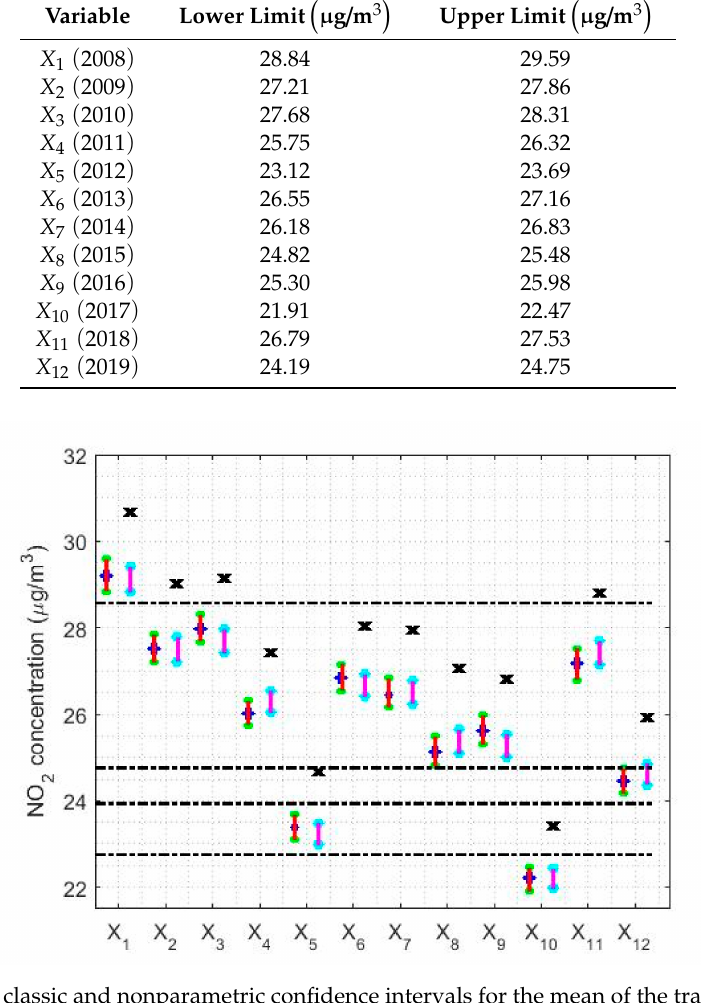
Figure 11. 95% classic and nonparametric confidence intervals for the mean of the transformed data and the median of the untransformed data, respectively. The nonparametric confidence interval is shown to the left of each variable and the classical confidence interval to the right of each variable. The x above each confidence interval is the mean of the untransformed variable, and the horizontal dashed lines are used to separate the categories. X 1 ( 2008 ) , X 2 (2009 ) , X 3 (2010 ) , X 4 (2011 ) , X 5 (2012 )